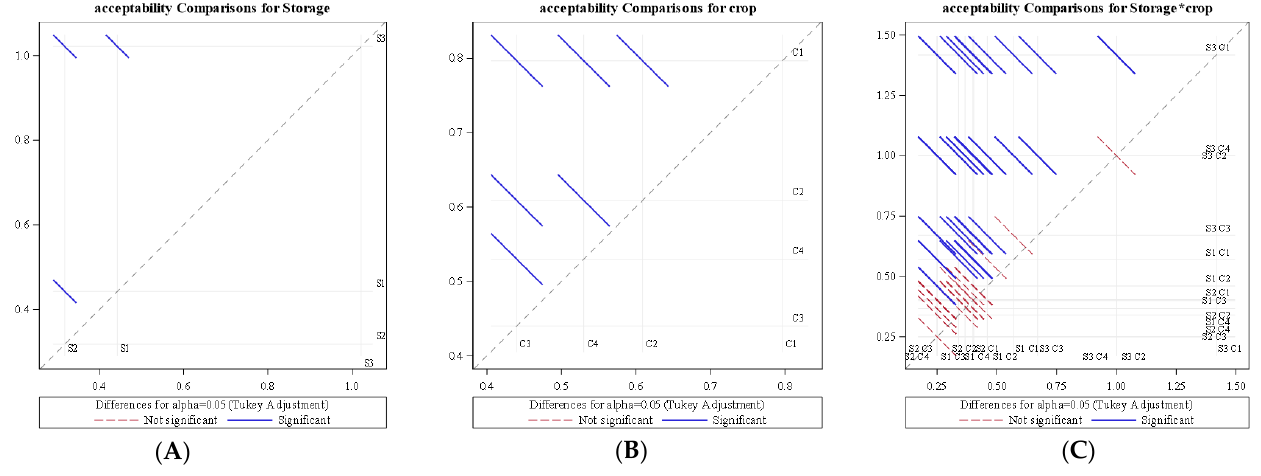
Figure 12. Diffogram showing the effect of storage condition and crop on average daily change of overall acceptability. (A) Acceptability comparison for storage (B) Acceptability comparison for